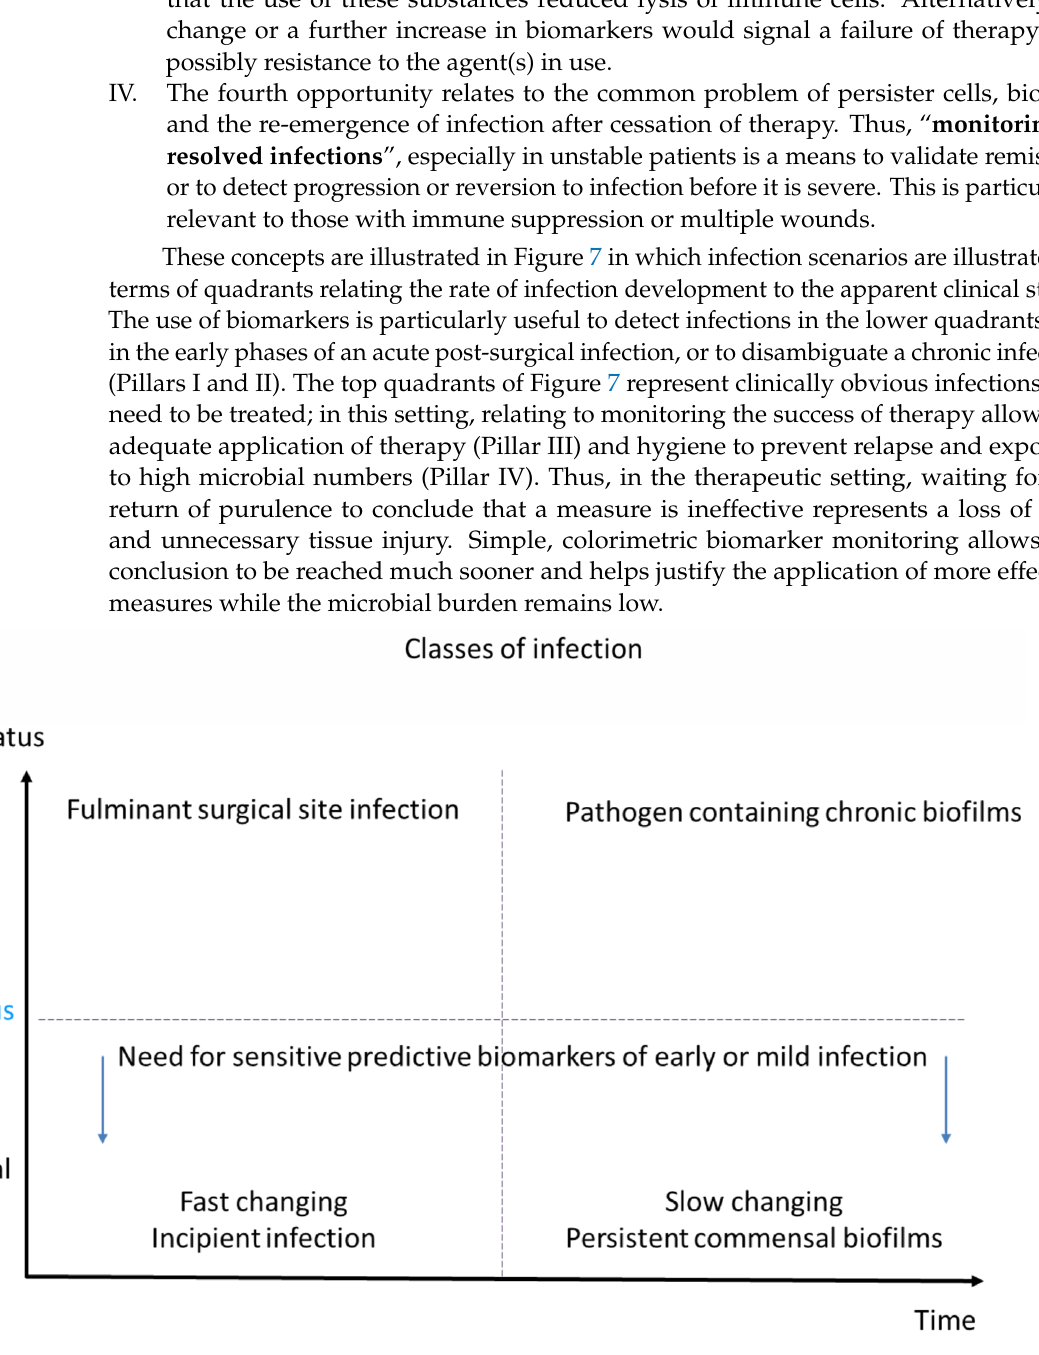
Figure 7. Classification of infection in terms of time, duration, and severity. The X-axis indicates two rates of infection progression—early onset, and prolonged—in terms of the time required for the signs to become visible. The Y-axis indicates three broad conditions of infection from sub-clinical (not visible) to ambiguous (some signs but not obvious) and clear advanced infection. The diagnostic challenge is to detect infections in the sub-clinical state or when wound state appears ambiguous. Should it be possible to detect incipient infection or sub-clinical persistent biofilms, this will have a major impact on treatment